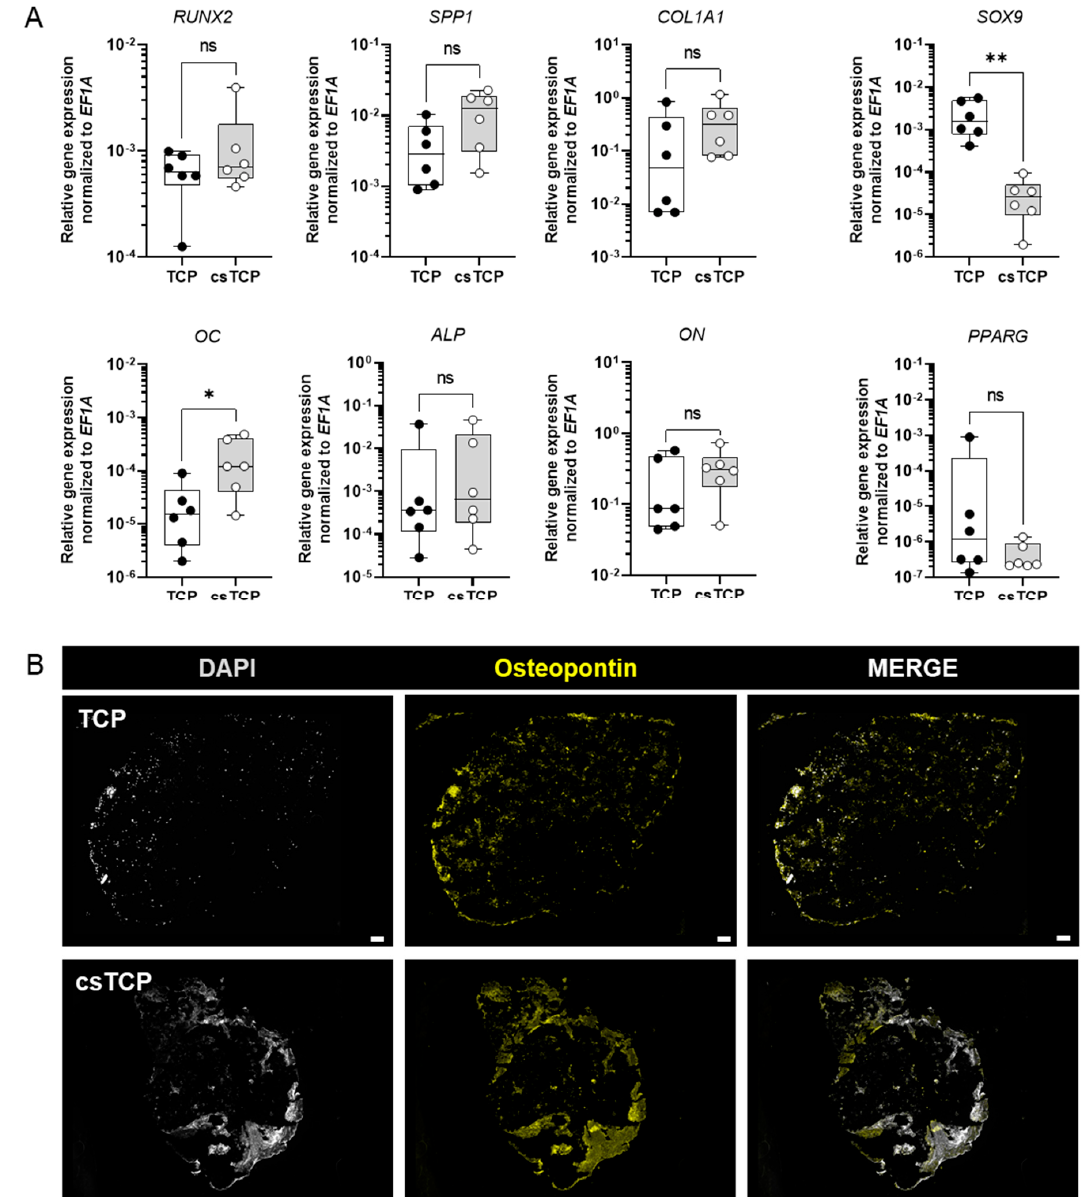
Figure 4. RNA expression analysis at day 21 showed that sheet technology slightly enhances osteogenic tissue formation in vitro. ( A ) Relative expression of osteogenic marker genes. Total RNA extraction was performed on day 21. Data are normalized to the housekeeper gene EF1A . Data are shown as box plots (centerline, median; box limits, upper and lower quartiles; whiskers, maximum and minimum values; all data points); n = 6. Statistics: Two-tailed Mann Whitney U test. p -values are indicated in the graphs with * p < 0.05, ** p < 0.01, ns = not significant. ( B ) Exemplary images of histological sections stained for osteopontin and visualized using a BZ-9000 fluorescence microscope ( n = 5). Scale bars show 100 µm.